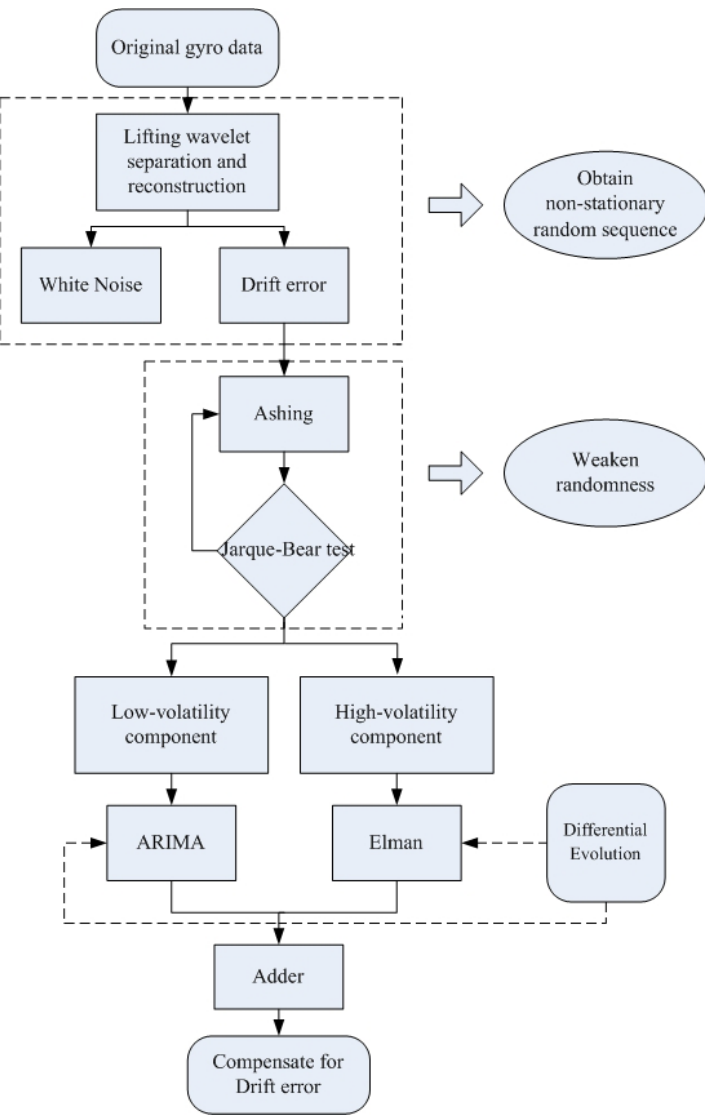
Figure 8. Flow chart of the hybrid ARIMA-Elman